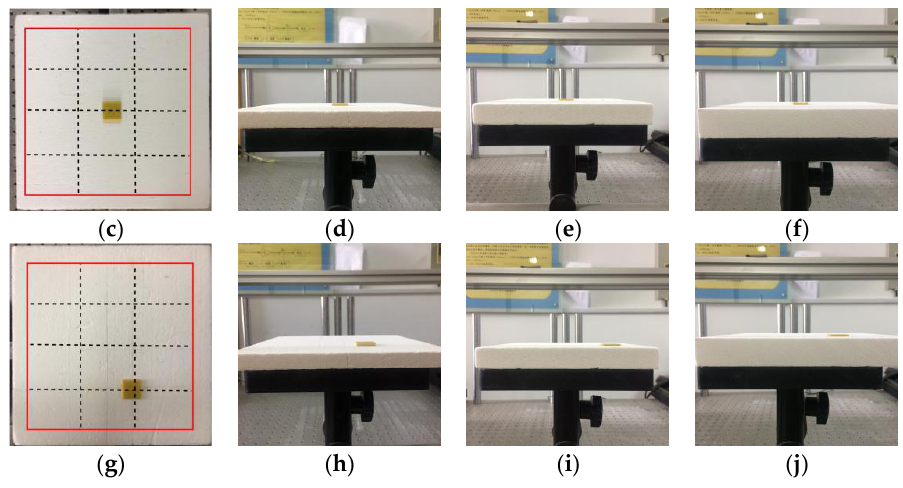
Figure 12. Test samples: ( a ) high calibration; ( b ) low calibration; ( c ) sample 3, center defect; ( d ) sample 4, material thickness 15 mm; ( e ) sample 5, material thickness 20 mm; ( f ) sample 6, material thickness 25 mm; ( g ) sample 7, edge defect; ( h ) sample 8, material thickness 15 mm; ( i ) sample 9, material thickness 20 mm; and, ( j ) sample 10, material thickness 25 mm.